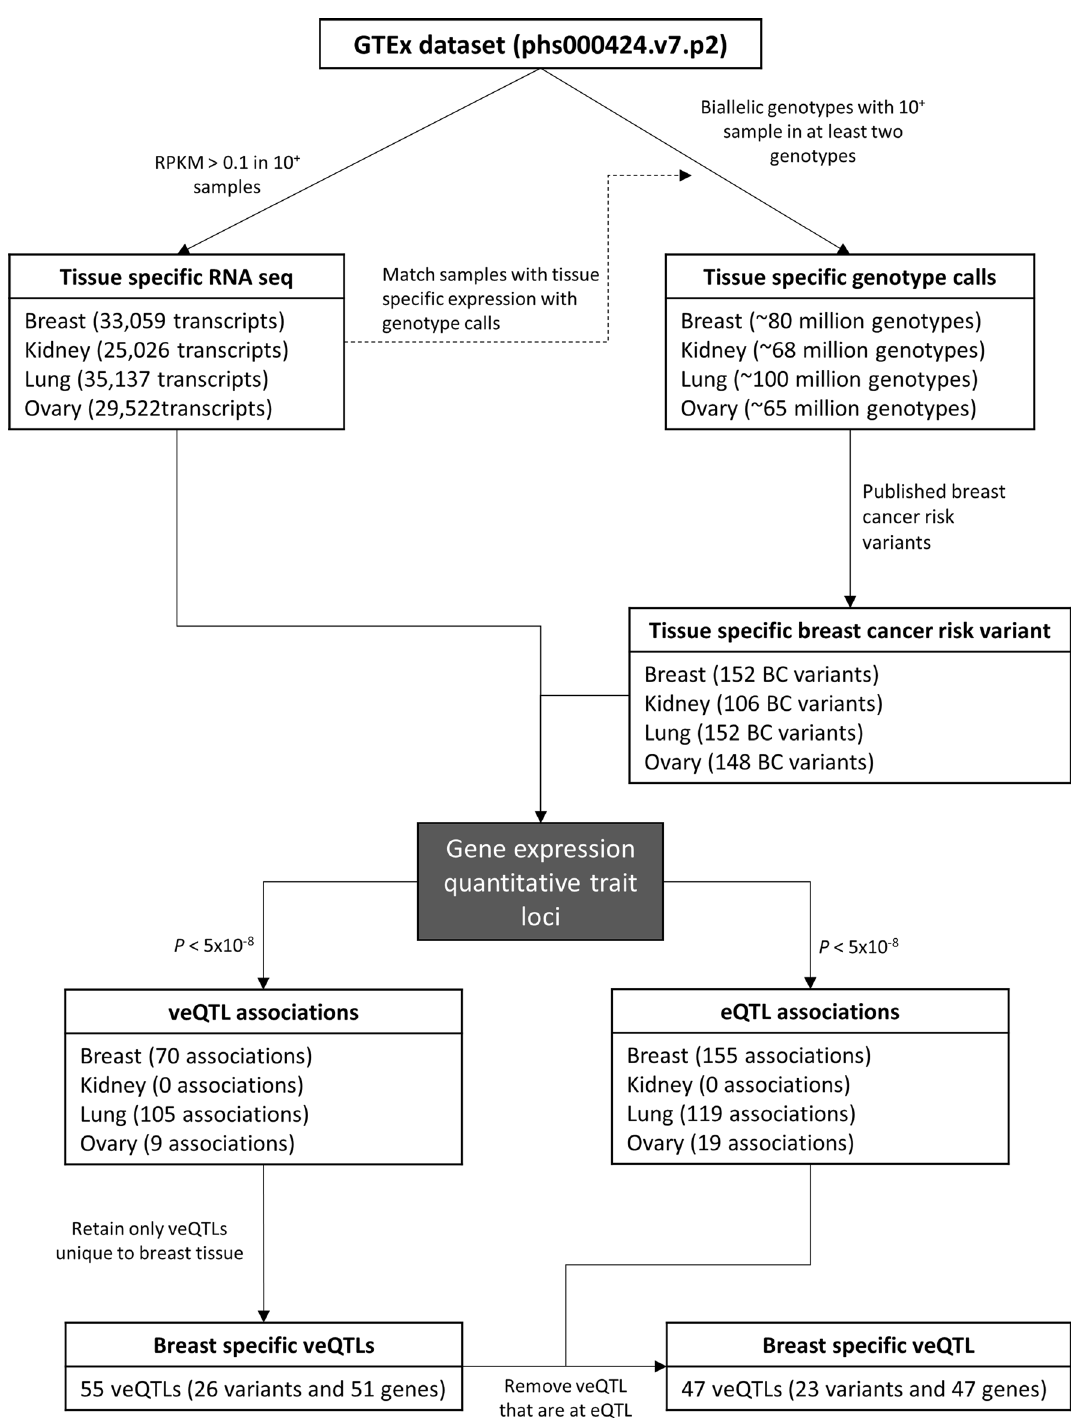
Figure 1. Schematic of study rationale to identify veQTL and eQTL in four different tissue types. Firstly, gene expression data from GTEx was filtered to remove lowly expressed genes and samples with tissue-specific expression data was matched with genotype calls. Tissue-specific QTL analyses was performed on the breast cancer risk variants identified by previous